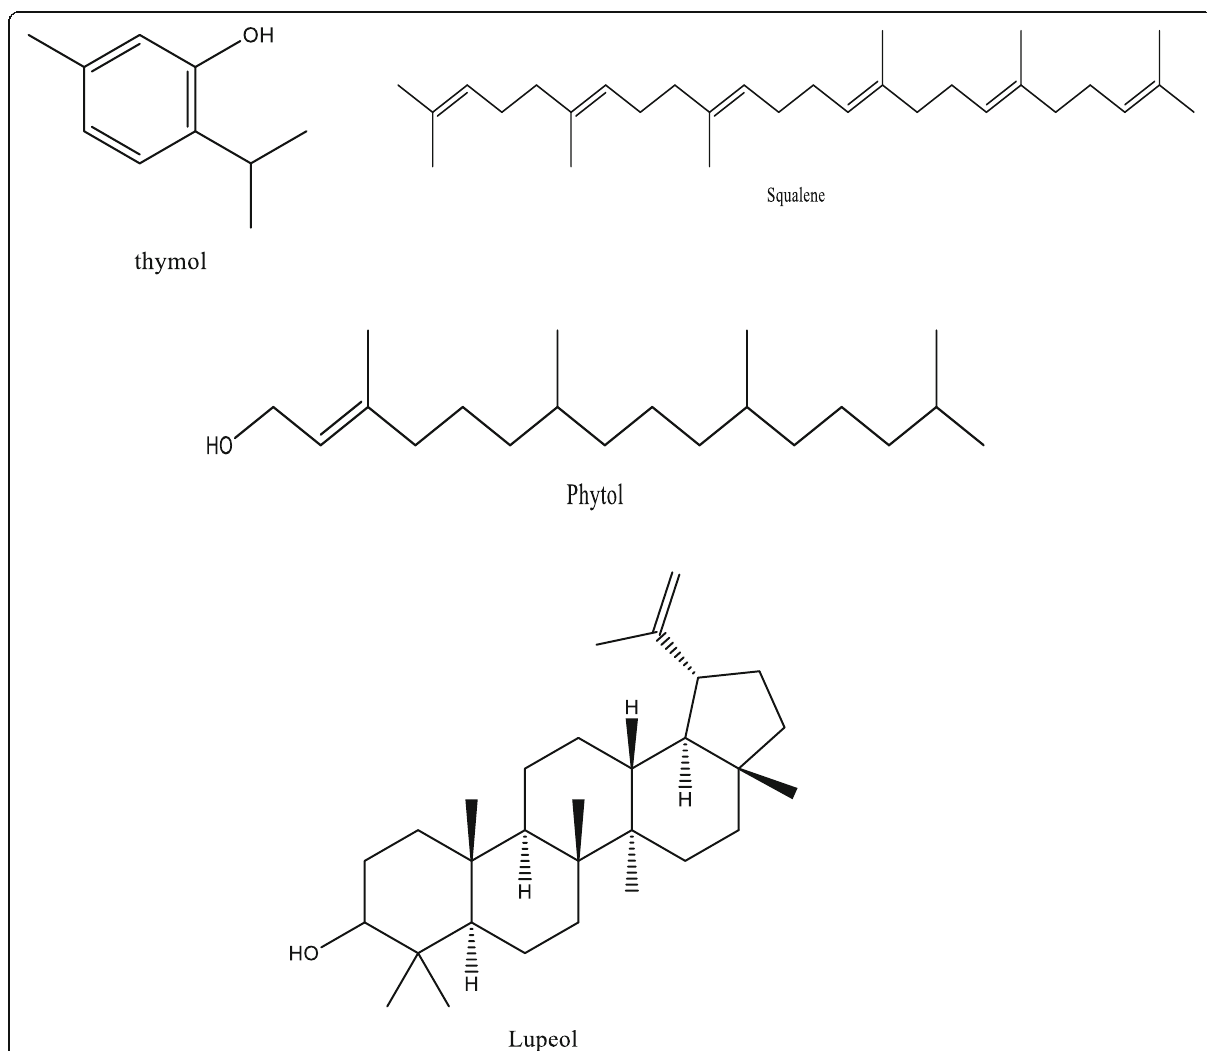
Fig. 15 Chemical structures of some terpenoids isolated from A. vera and A. ferox